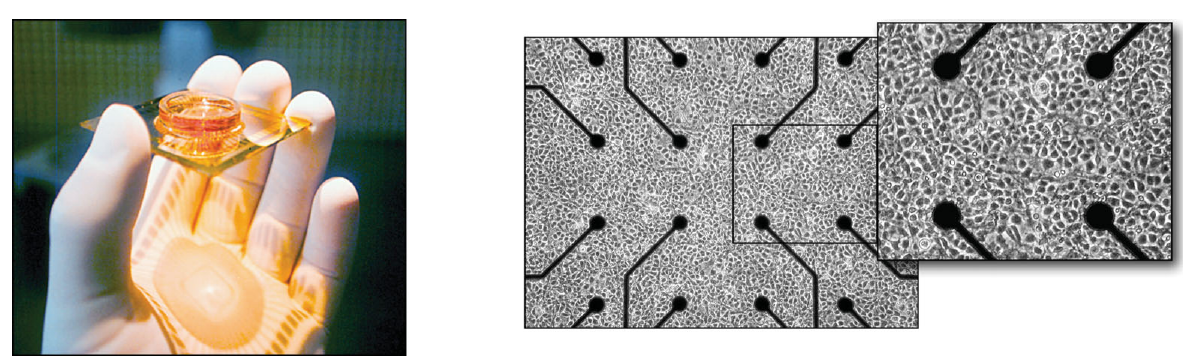
Figure 2. MEART’s brain (above) and a MEA culture dish (below). A week-old culture of ∼ 50000 neurons and glia from embryonic rat cortex, growing in a MEA and forming a dense network 1–2mm across. Fifty-nine 30 µ m electrodes spaced at 200 µ m intervals connect a few hundred of the network’s neurons to the outside world, by allowing their activity to be extracellularly recorded or evoked by electrical